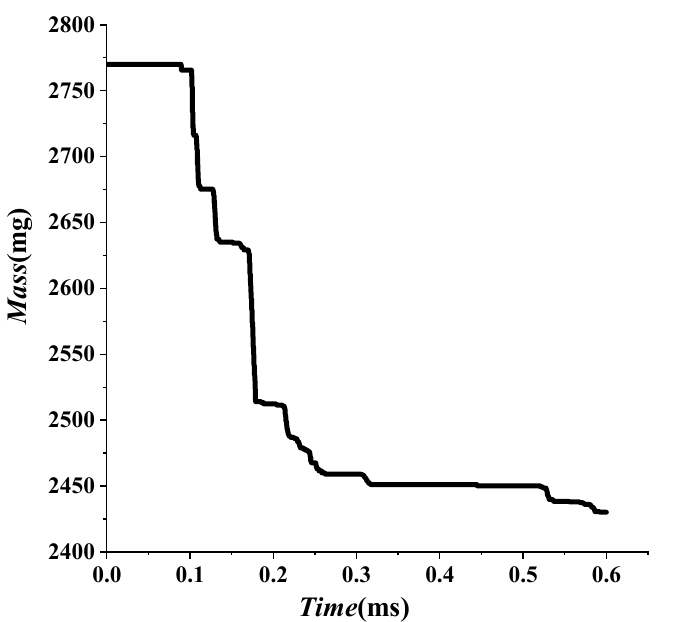
Figure 16. Evolution of mass of the shaped charge projectile in water.